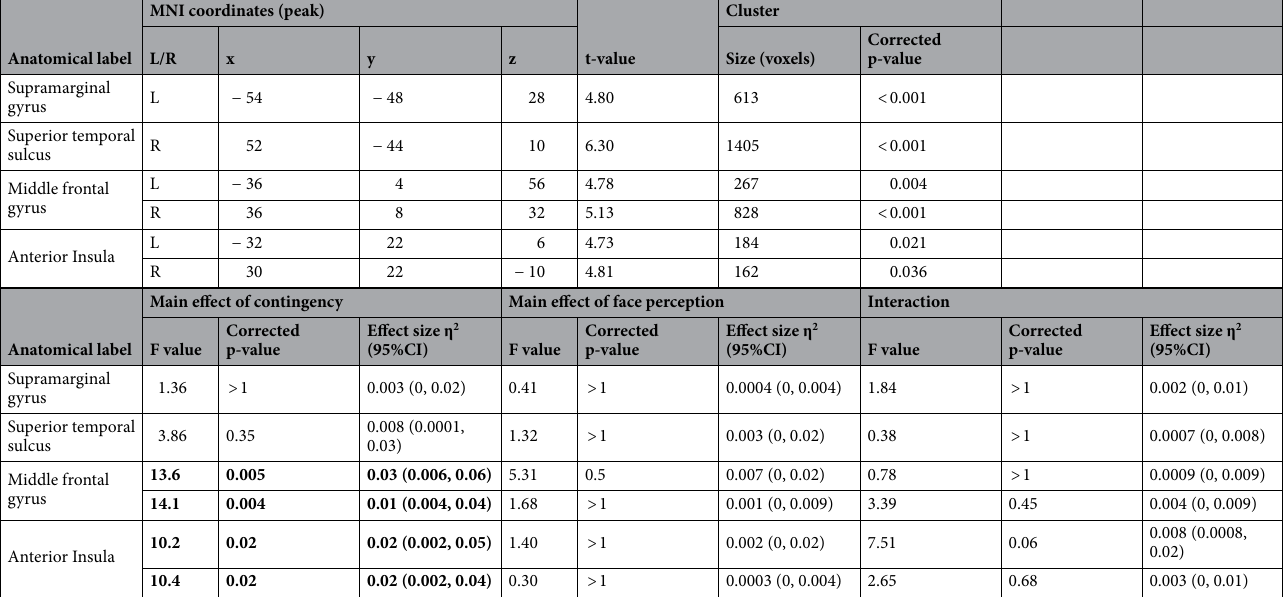
Table 1. Brain regions with a negative contingency effect and results of region of interest (ROI) analysis. For each activation peak, the Montreal Neurological Institute (MNI) coordinates (x, y, and z), t-value, cluster size (voxel size = 2 × 2 × 2 mm 3 ), corrected P , and ROI results are described. Peaks represent the negative contingency effect contrast (i.e., [FN + ON] > [FC + OC]) at P < 0.001 (uncorrected), which were corrected according to a family-wise error of P < 0.05 based on cluster size. L and R indicate left the (L) and right (R) hemispheres, respectively. The nine right columns provide the ROI analysis results for the recognition phase. The significance threshold of the ROI analysis was Bonferroni-corrected ( P < 0.05) because multiple comparisons were performed. The F and P -values of significant effects are indicated in bold. CI confidence interval, FC face contingent, FN face non-contingent, OC object contingent, ON object